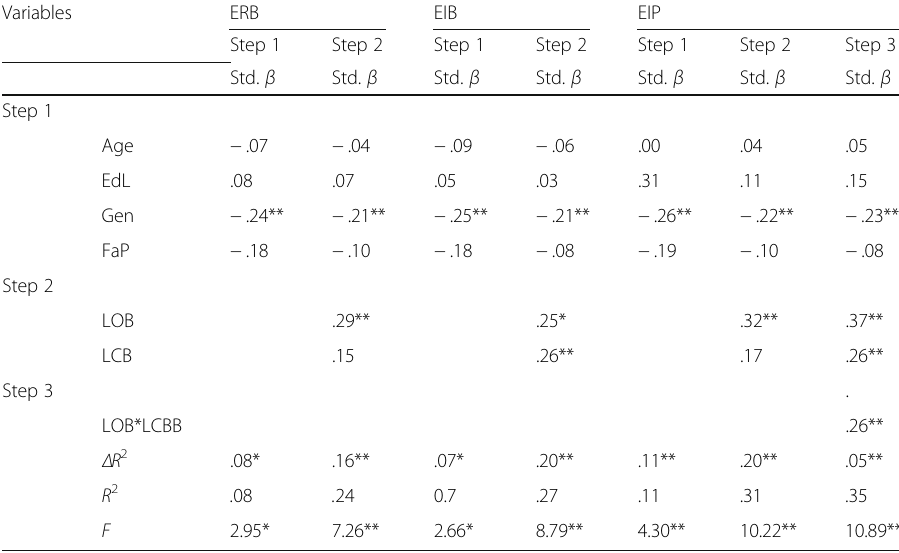
Table 3 Results of hierarchical regression analysis Variables